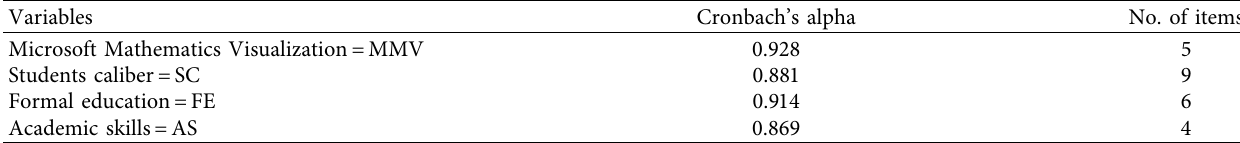
Table 1: Data reliability.